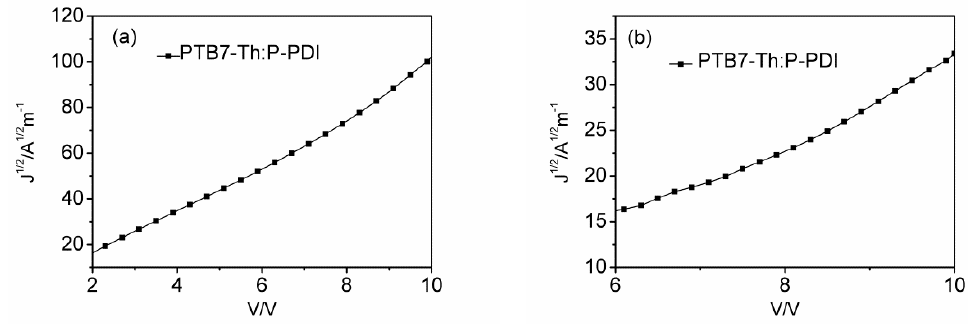
Figure 3. J 1 / 2 -V curves for determining the µ h ( a ) and µ e ( b ) curves of PTB7-Th:P-PDI based optimized devices.